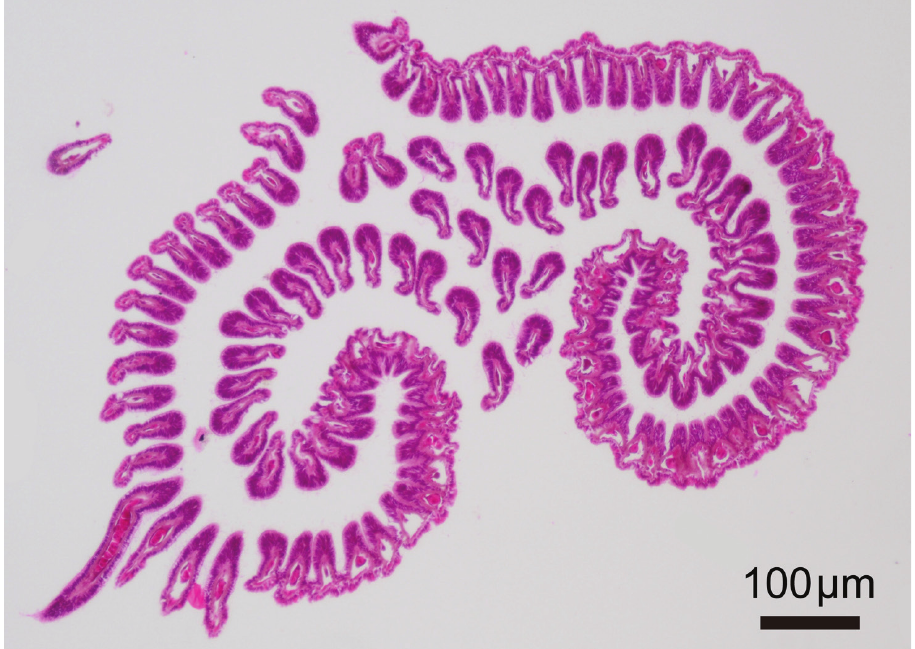
Figure 4. Phoronis ijimai Oka, 1897, NSMT-Te 885, transverse section through basal part of